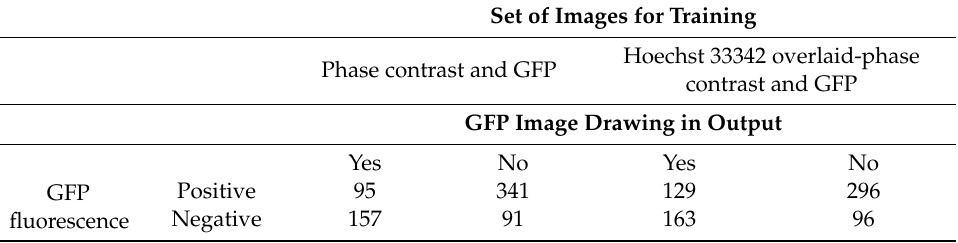
Table 1. Classification of cancer stem cells (CSCs) output images in tumor tissue Set of Images for Training Phase contrast and